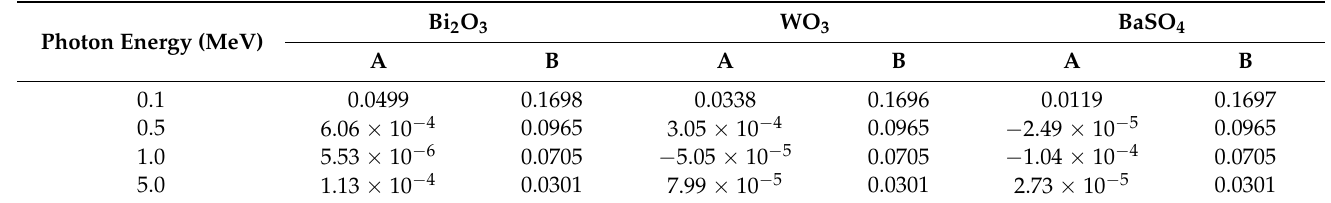
Table 2. Mathematical constants (A and B) for µ m in the form µ m = Ax + B (Equation (1)), determined from Figure 4.